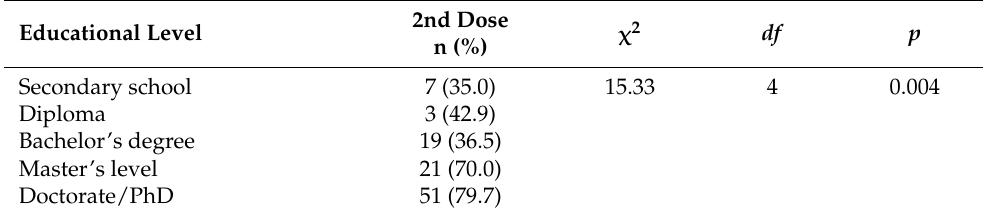
Table 4. Frequencies and Percentage of the Participants who Received Two Doses of the Vaccine